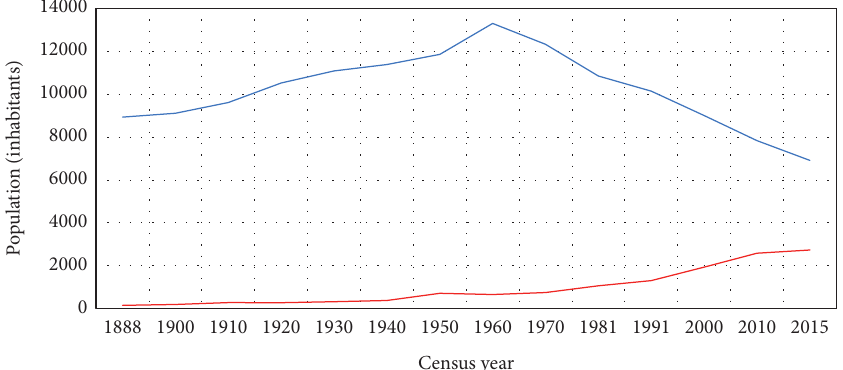
Figure 7: Population in the capital town (red line) and the whole municipality excluding the capital town (blue line) between 1888 and